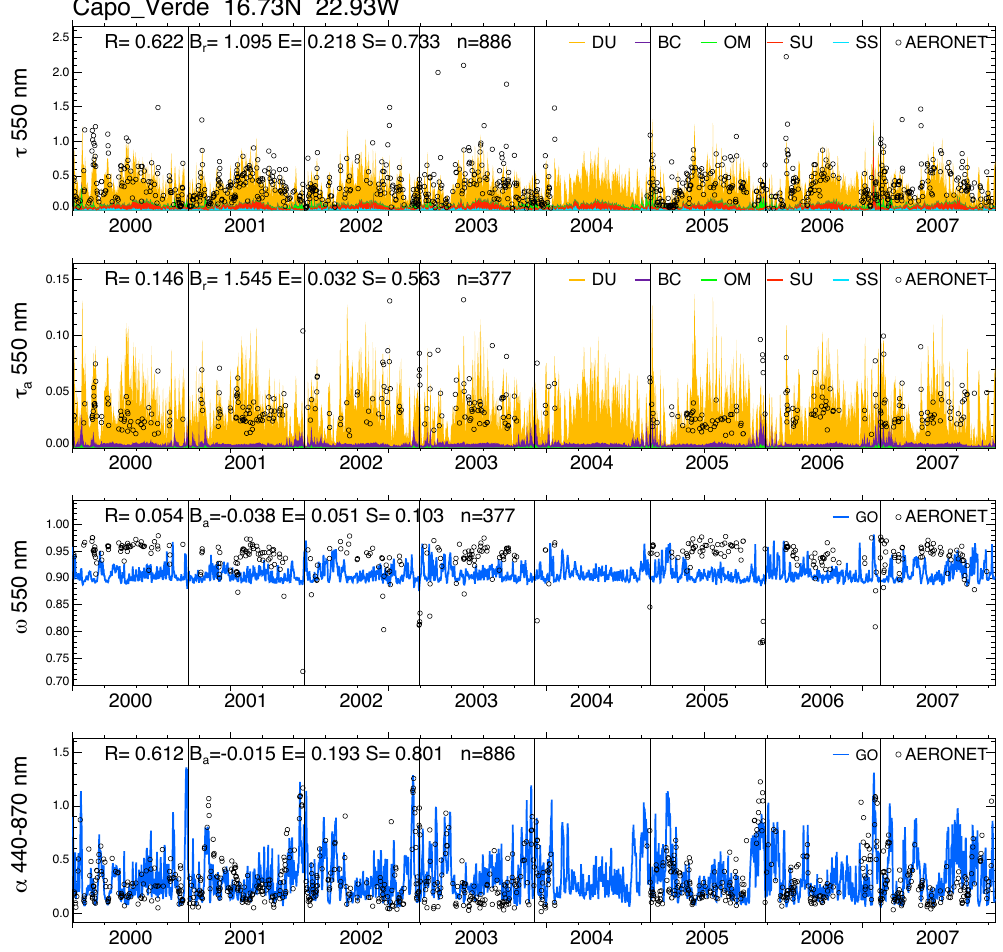
Fig. 5e. Same as Fig. 5a but for Cape Verde, off the west coast of northern